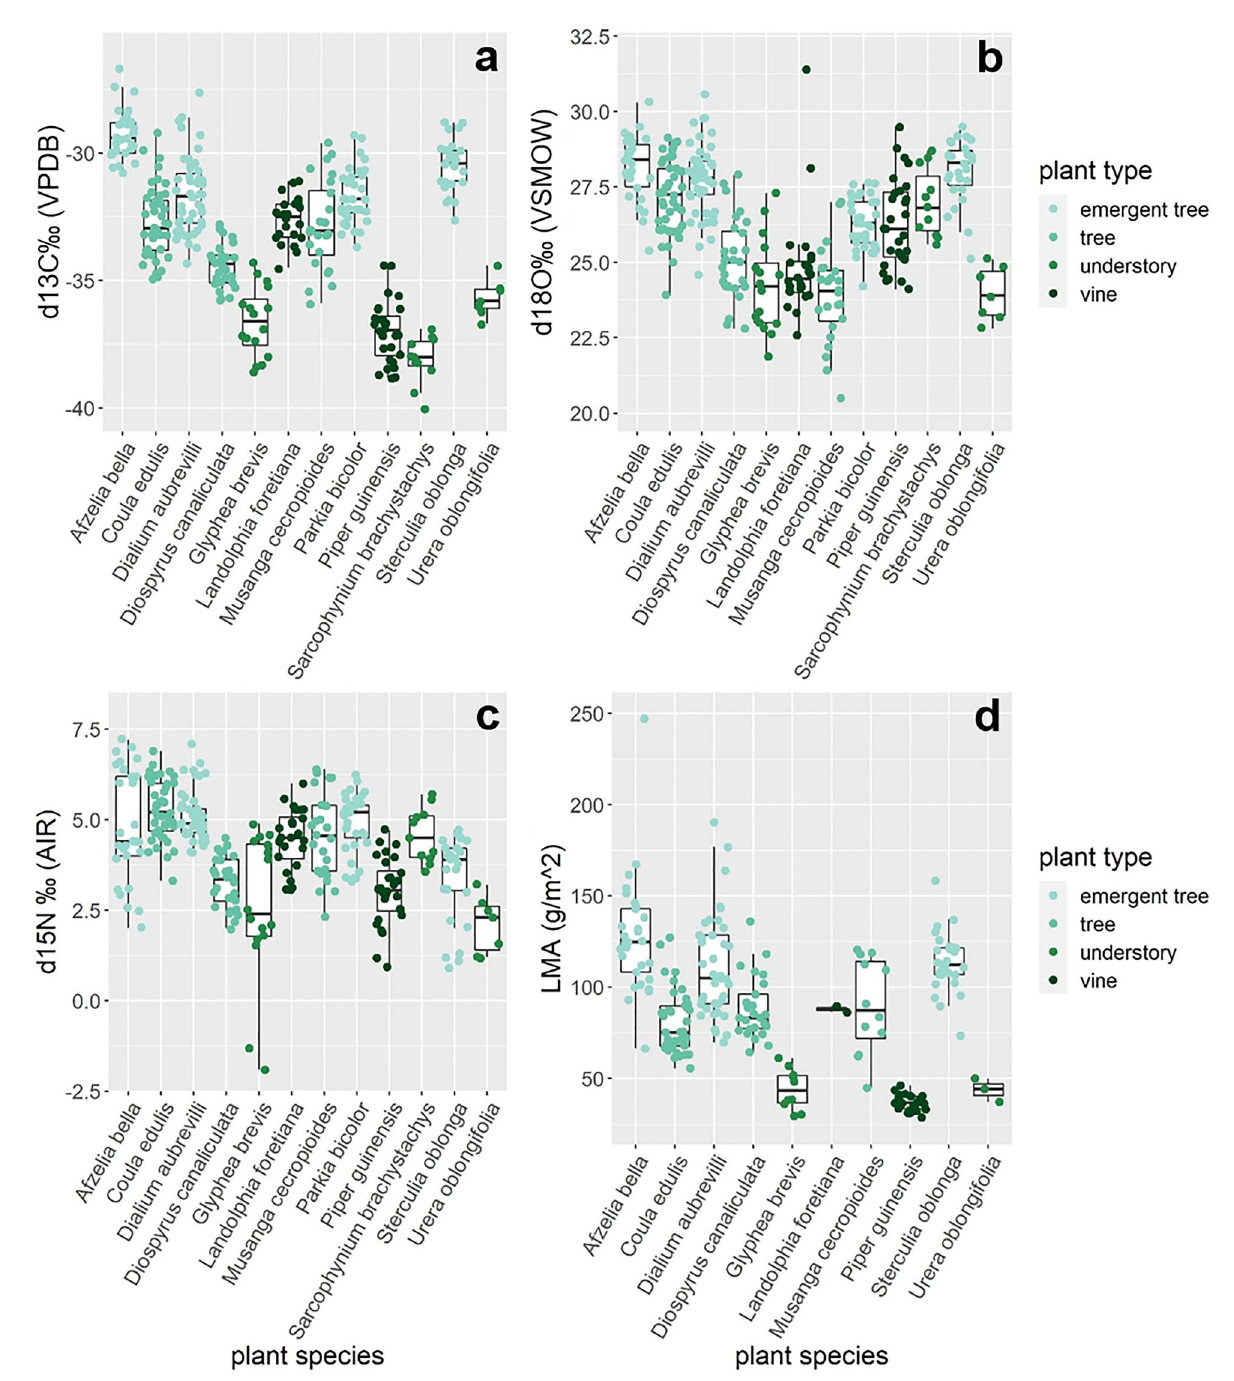
Figure 2. Whisker plots illustrating the effects of tree species on the variation in ( a ) δ 13 C, ( b ) δ 18 O, ( c ) δ 15 N and ( d ) PAR values within